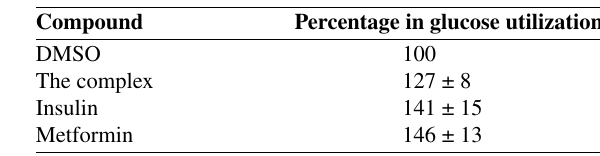
Table 5. Glucose uptake in C2C12 cell line results